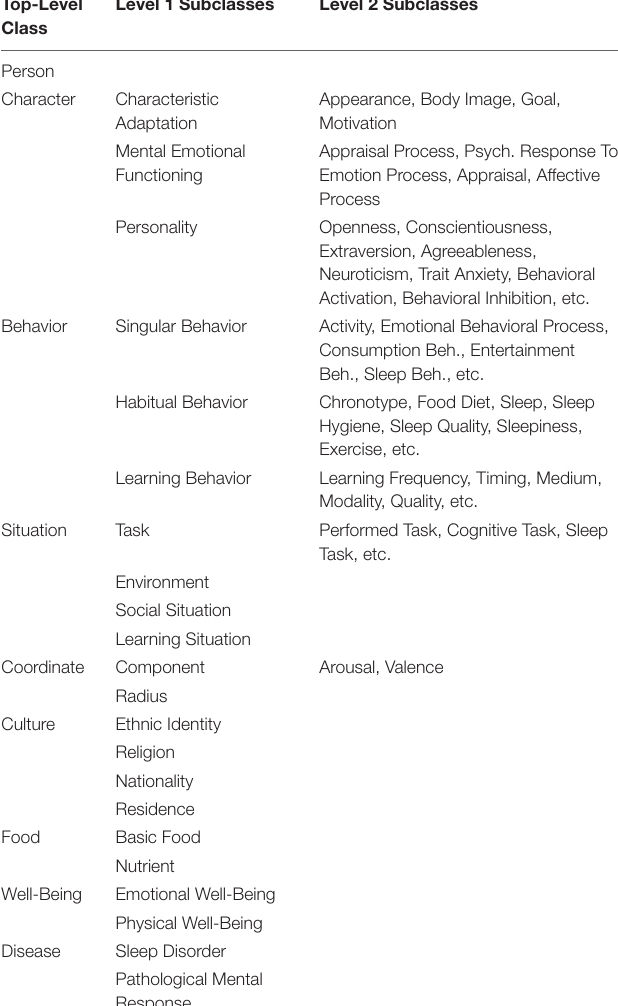
TABLE 1 | The abstracted hierarchy of the main upper-level classes of CCOnto relevant to the example presented in this manuscript.